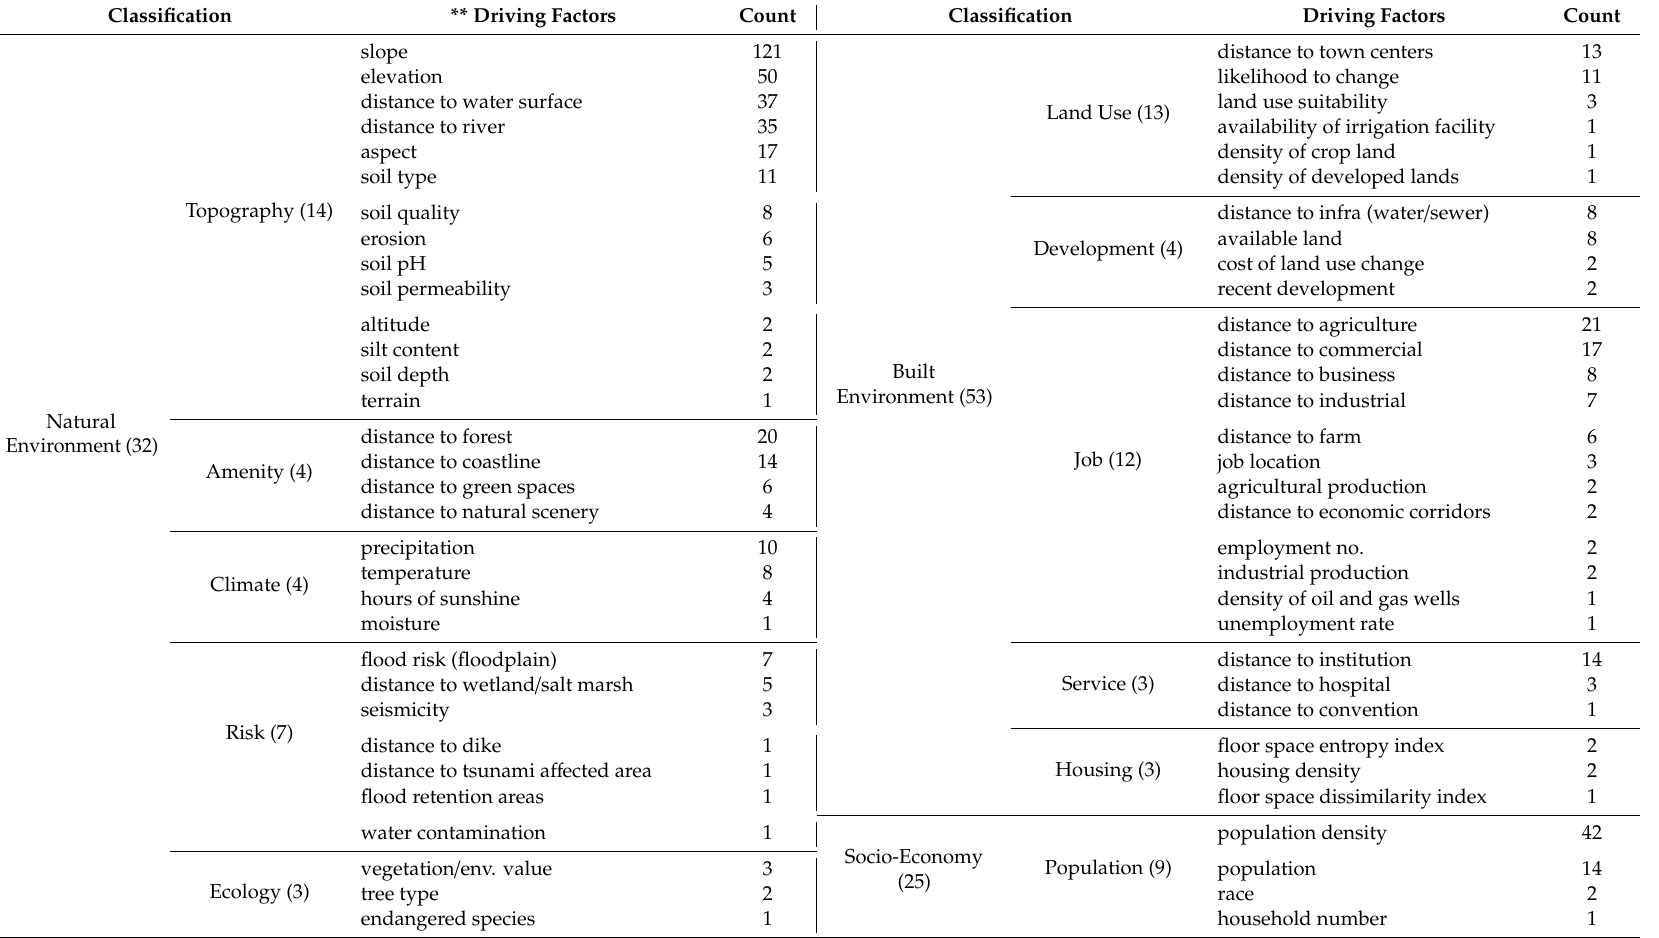
Table 2. List of predictor variables in the reviewed LCM articles